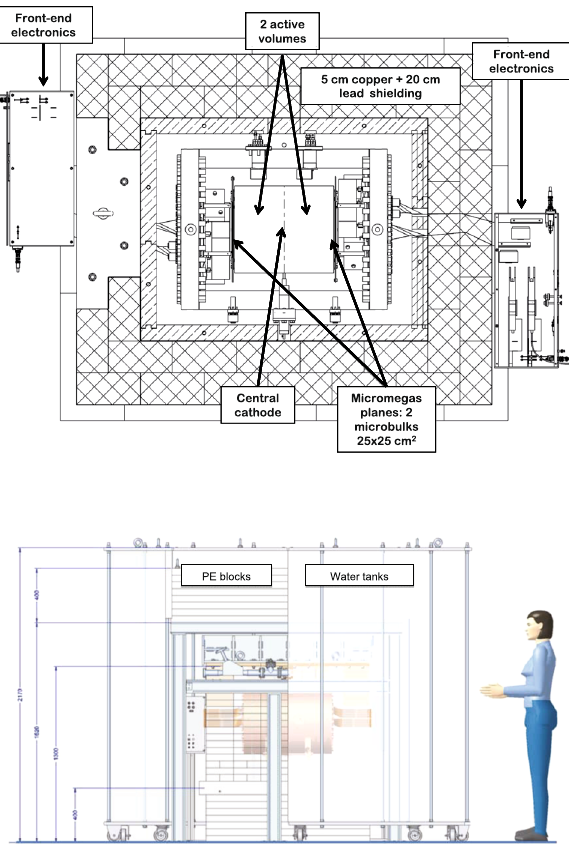
Fig. 3 Energy spectrum obtained in the characterization of microbulk Micromegas with Ar (top) and Ne (bottom) mixtures using a 109 Cd source at 10 bar. The results of a multi-Gaussian fit for estimating the FWHM at 22.1 keV are shown. The fitted peak is generated by the K α (22.1 keV) and K β (24.9 keV) X-ray lines produced by the source, as well as their corresponding escape peaks. The copper K-fluorescence induced by the source at the copper components close to the gas volume is clearly identified at 8